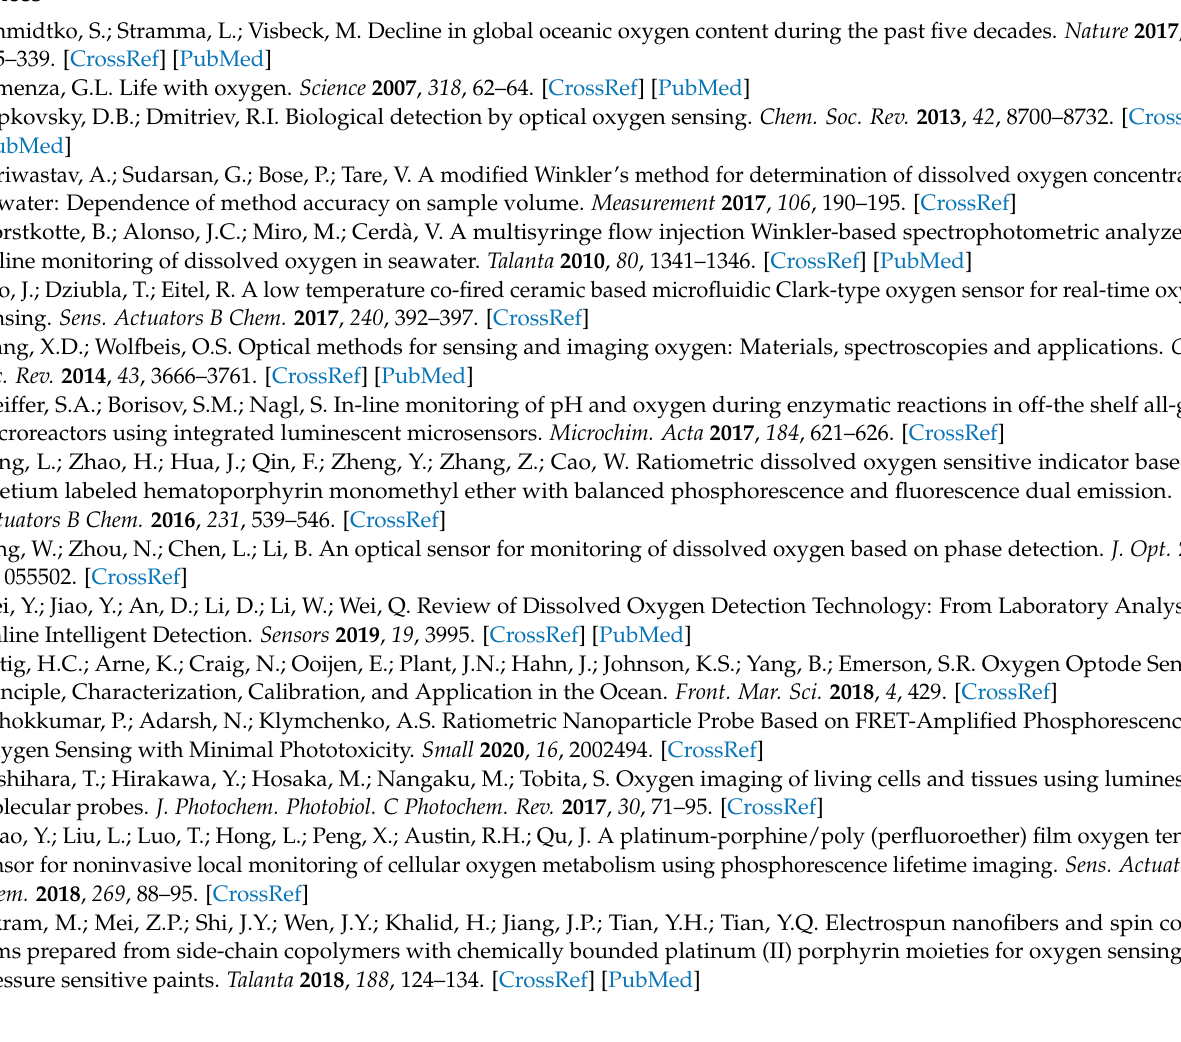
Figure A2. The images show each functional interface of a smartphone APP. ( a ) The main interface of the APP. ( b ) The interface for calibration setup. ( c ) The interface for detection setup.